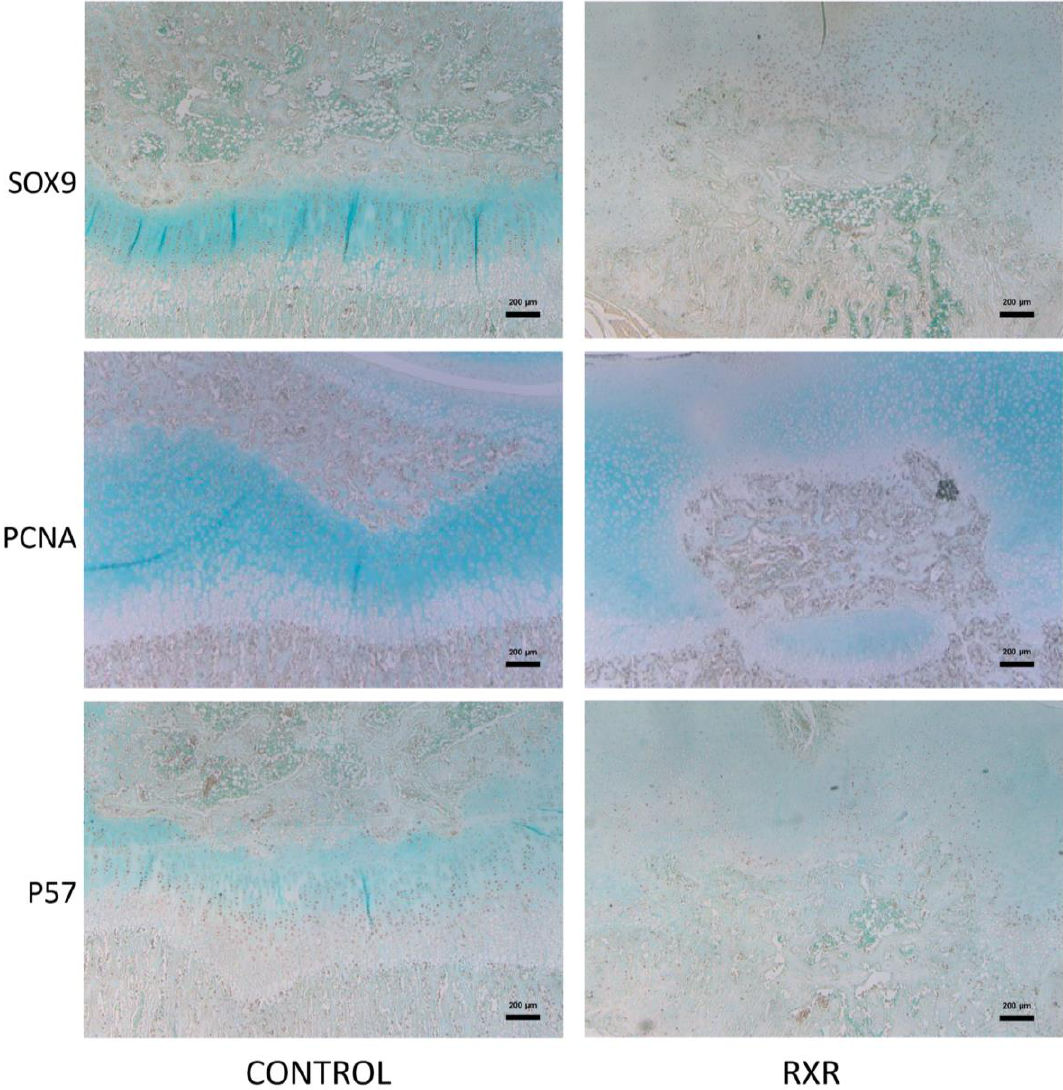
Figure 5. Immunohistochemistry staining of P16 rat tibial sections. Sections of tibiae from rats treated with DMSO or SR11237 were examined by immunohistochemistry for various markers. PCNA is a proliferative marker; P57 demonstrates the arrangement of terminally differentiating chondrocytes in the hypertrophic region; SOX9 shows the organization of proliferating chondrocytes (scale bar = 200 μm).